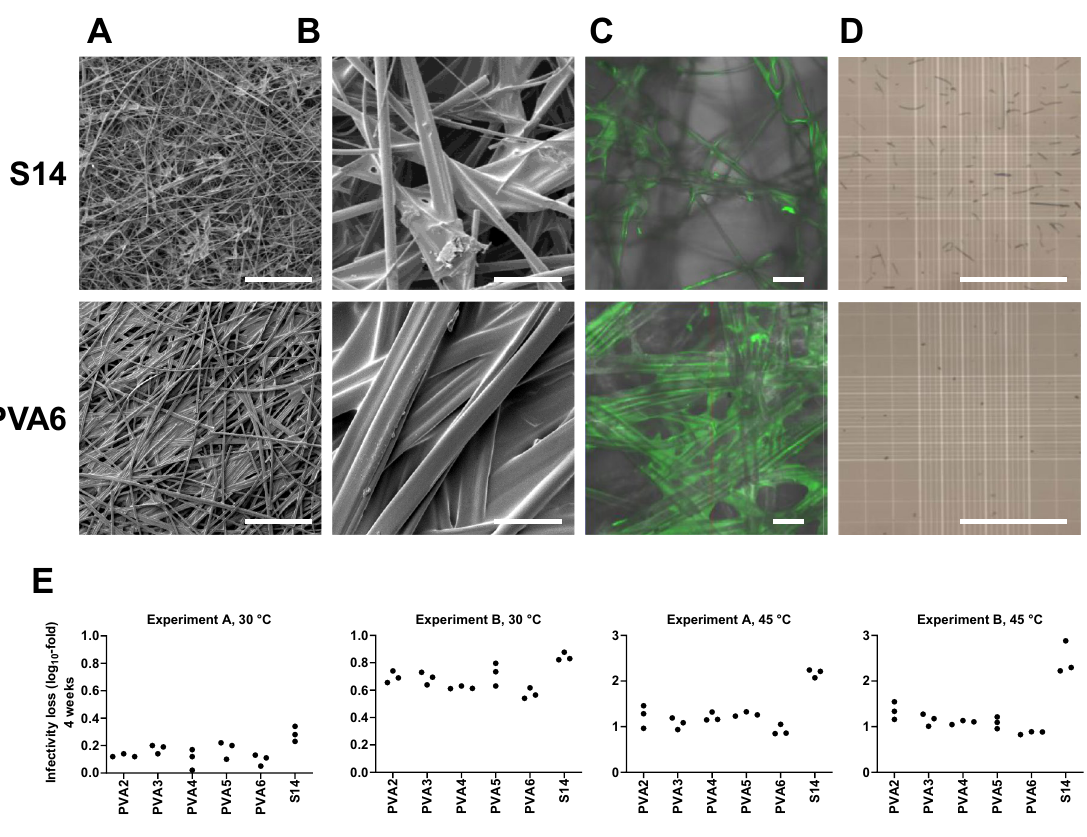
Figure 7. Characterisation of PVA matrices. Panels ( A )–( D ) compare S14 (upper row of images) and PVA6 (lower row). Images with matrices PVA2-5 were similar to those shown for PVA6. Panels ( A )–( C ) show the distribution of sugar-glass film after drying of 0.5 M (50:50) trehalose:sucrose solution (50 μL/cm 2 ): ( A ) shows SEM at low magnification (scale bar = 500 μm); ( B ) shows SEM at higher magnification (scale bar = 50 μm); ( C ) shows confocal laser scanning microscopy of the distribution of fluorescein-labelled lysozyme within the film (scale bar = 50 μm). ( D ) Show results of light microscopy for subvisible particle detection after reconstitution of dried 0.5 M (50:50) trehalose:sucrose solution (scale bar = 1 mm). ( E ) compares loss in infectivity titre of vaccine post-thermochallenge between PVA-based matrices (PVA2-6) and S14 glass fibre matrix. As indicated in the graph headings, dried samples were subjected to thermochallenge for 4 weeks at 30 or 45 °C, and the experiment was performed in duplicate. Points indicate individual samples (three replicates per